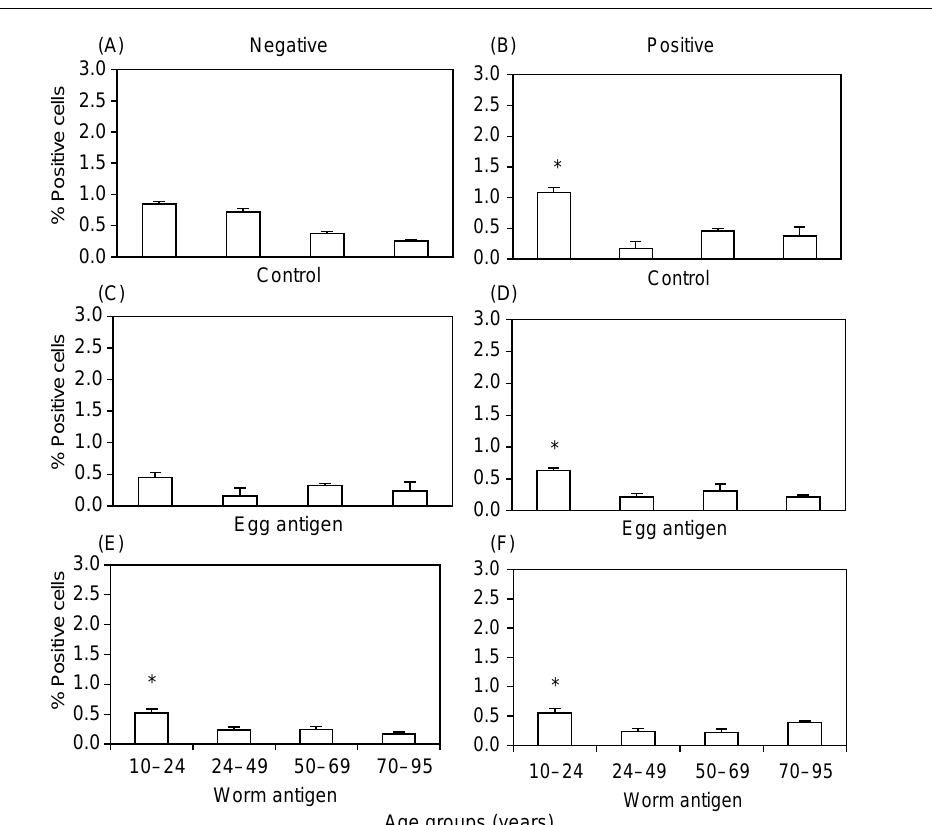
FIG. 3. Frequency of CD8 (cid:2) INF- g (cid:2) cells were analyzed according to age and infection status in individuals from areas endemic for Schistosomiasis in Brazil. Seventy-one individuals from 10 to 95 years of age were analyzed in a cross-sectional study. Individuals who scored negative in the stool test for S.mansonieggs were taken as negative subjects (A, C, E) and individuals who scored (cid:1) / 100 eggs per gram of feces (epg) were taken as positive subjects (B, D, F). Freshly collected blood cells from both groups of individuals were cultured in complete RPMI for 5 h with either medium alone (control) (A, B), or 25 m g/ml of soluble egg antigen (egg antigen) (C, D) or 25 m g/ml of soluble worm antigen (worm antigen) (E, F). Cells were then stained for CD8 and for IFN- g and analyzed by flow cytometry. Bars represent the average frequency of CD8 (cid:2) IFN- g (cid:2) cells 9 / standard deviation of each age group. A one-way analysis of variance procedure was used to test differences among age groups, *significant differences. Pairs of means of negative and positive individuals at the same age group were tested by Bonferonni post-hoc test, (cid:2) / significant differences. p B /